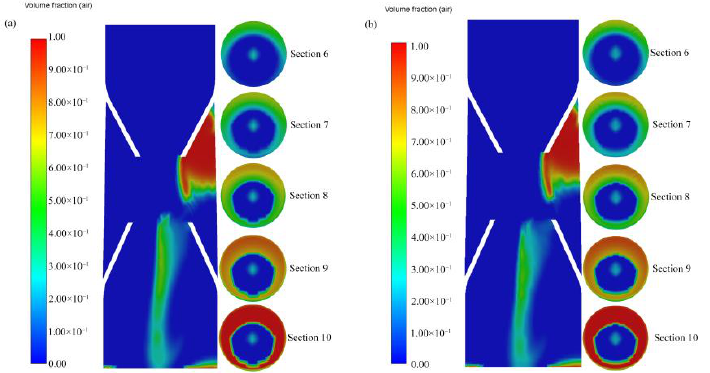
Figure 4. Cloud map of gas-phase distribution at an ( a ) inlet flow velocity 6.5 m/s and ( b ) inlet flow velocity 7.5 m/s.